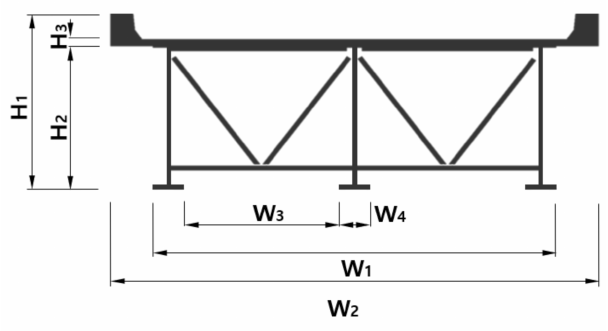
Figure 12. Design parameters for a plate girder bridge.